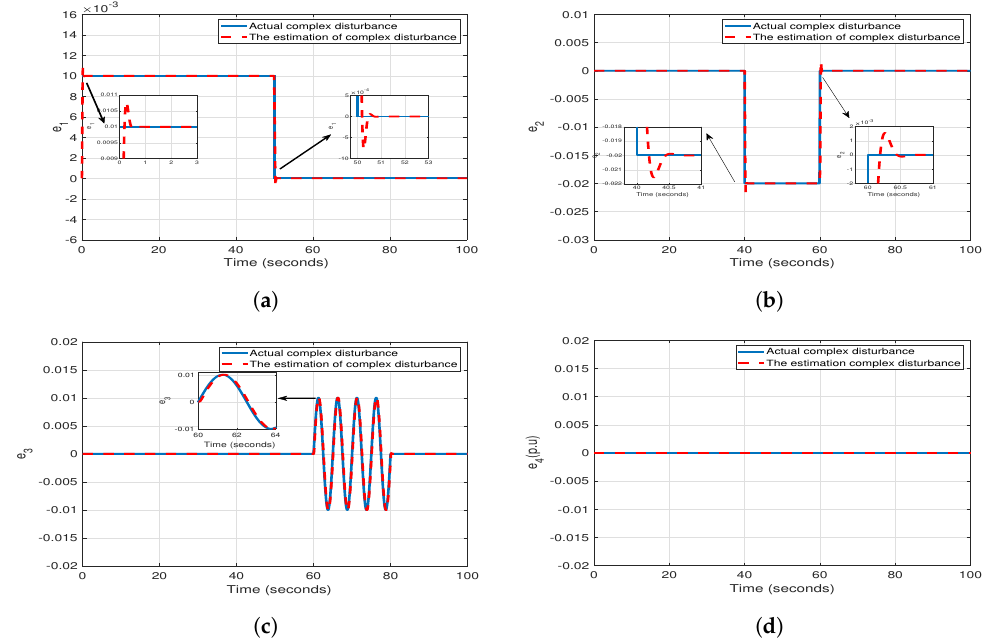
Figure 5. The four areas’ actual lumped disturbances and their estimation: ( a ) a lumped disturbance increment of 0.01 p.u followed by a lumped disturbance rejection of 0.01 p.u; ( b ) a lumped disturbance rejection of 0.02 p.u followed by a lumped disturbance increment of 0.02 p.u; ( c ) a sinusoidal lumped disturbance; ( d ) non-disturbance.